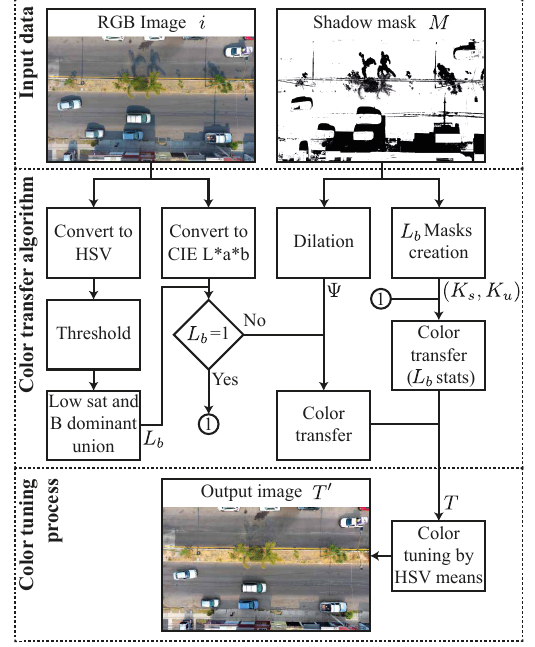
Figure 1. Proposed methodology.